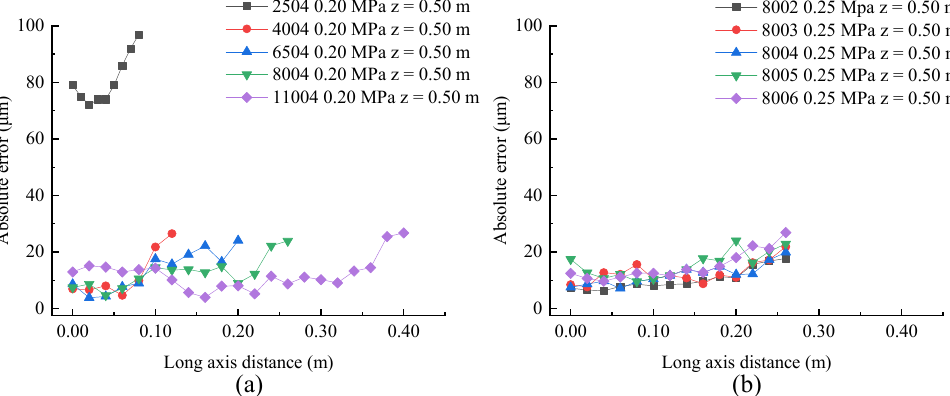
Figure 14. Absolute errors between the measured and theoretical data corresponding to the droplet size: ( a ) different spray angles; and ( b ) different flow rates.